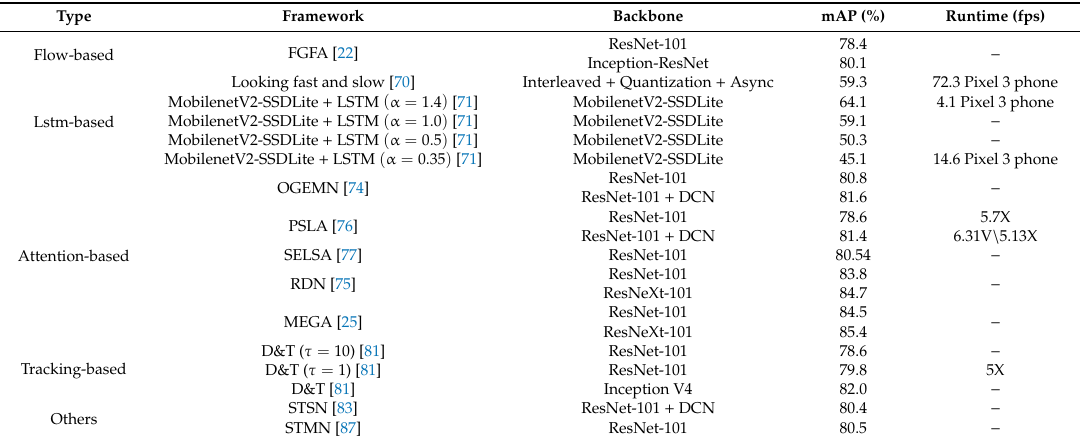
Table 5. Comparison among the video object detection methods with post